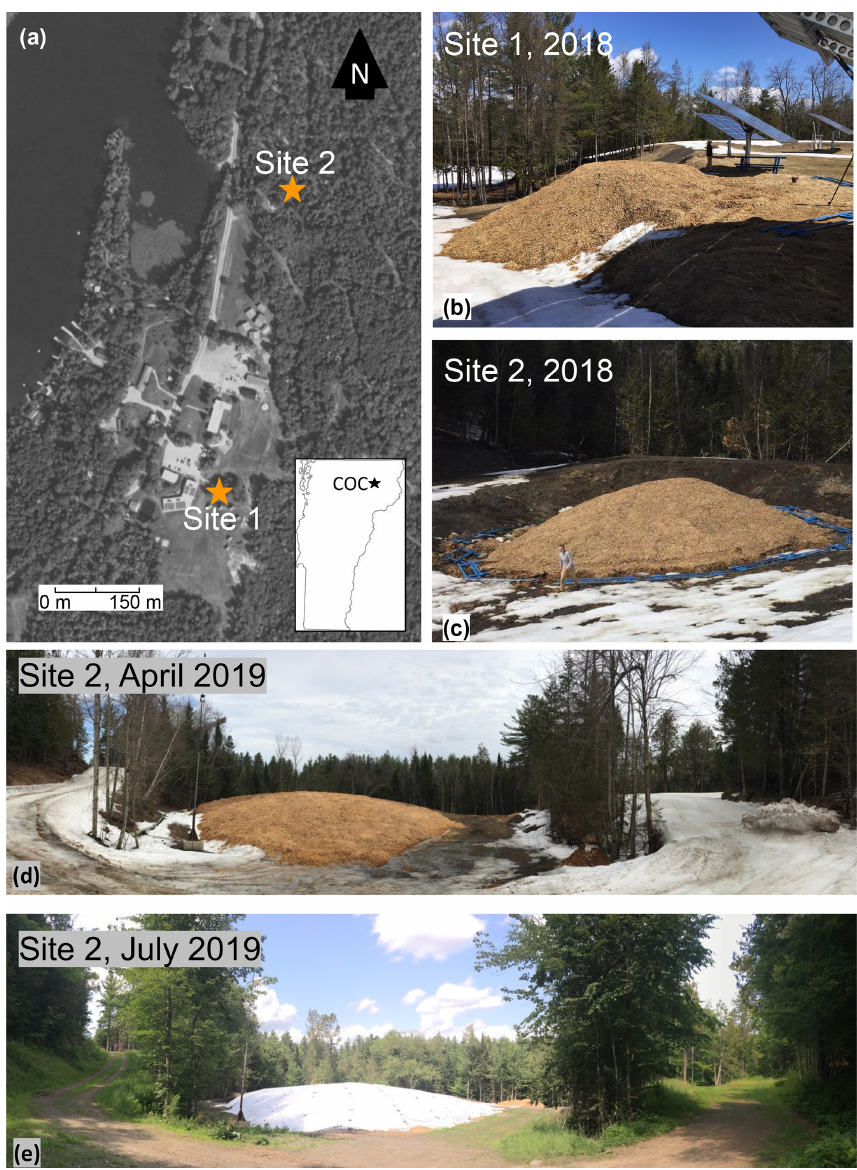
Figure 2. Snow storage at Craftsbury Outdoor Center. (a) Aerial view of the Craftsbury Outdoor Center (COC) in Vermont, from http: //maps.vcgi.vermont.gov (8 February 2019). Both study site locations shown by number. (b) Site 1 (225m 3 ), covered in woodchips on 21 April 2018, with trees and solar panels for scale. (c) Site 2 (209m 3 ) when installed. Site 1 received 24m 3 of woodchips, and Site 2 received 42m 3 of woodchips. Person for scale. (d) Site 2 in April 2019; 9300m 3 of snow, eventually covered with 650m 3 of